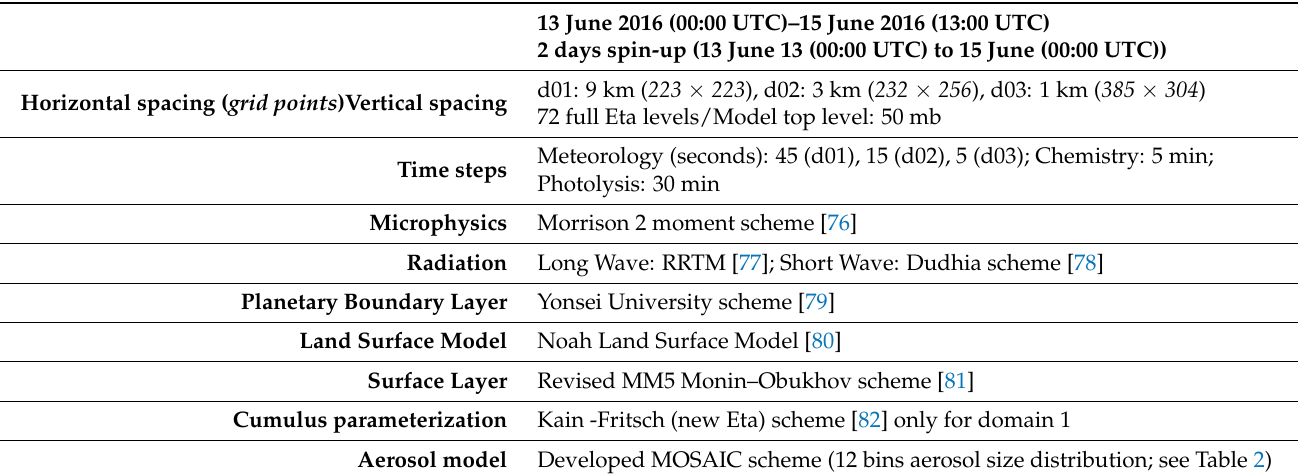
Table 1. WRF-Chem Configuration.